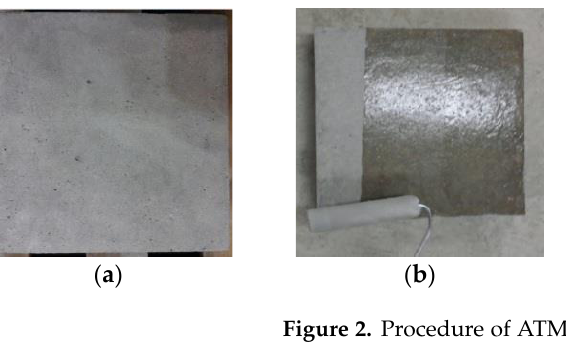
Figure 1. Schematic of ATMS implementation.